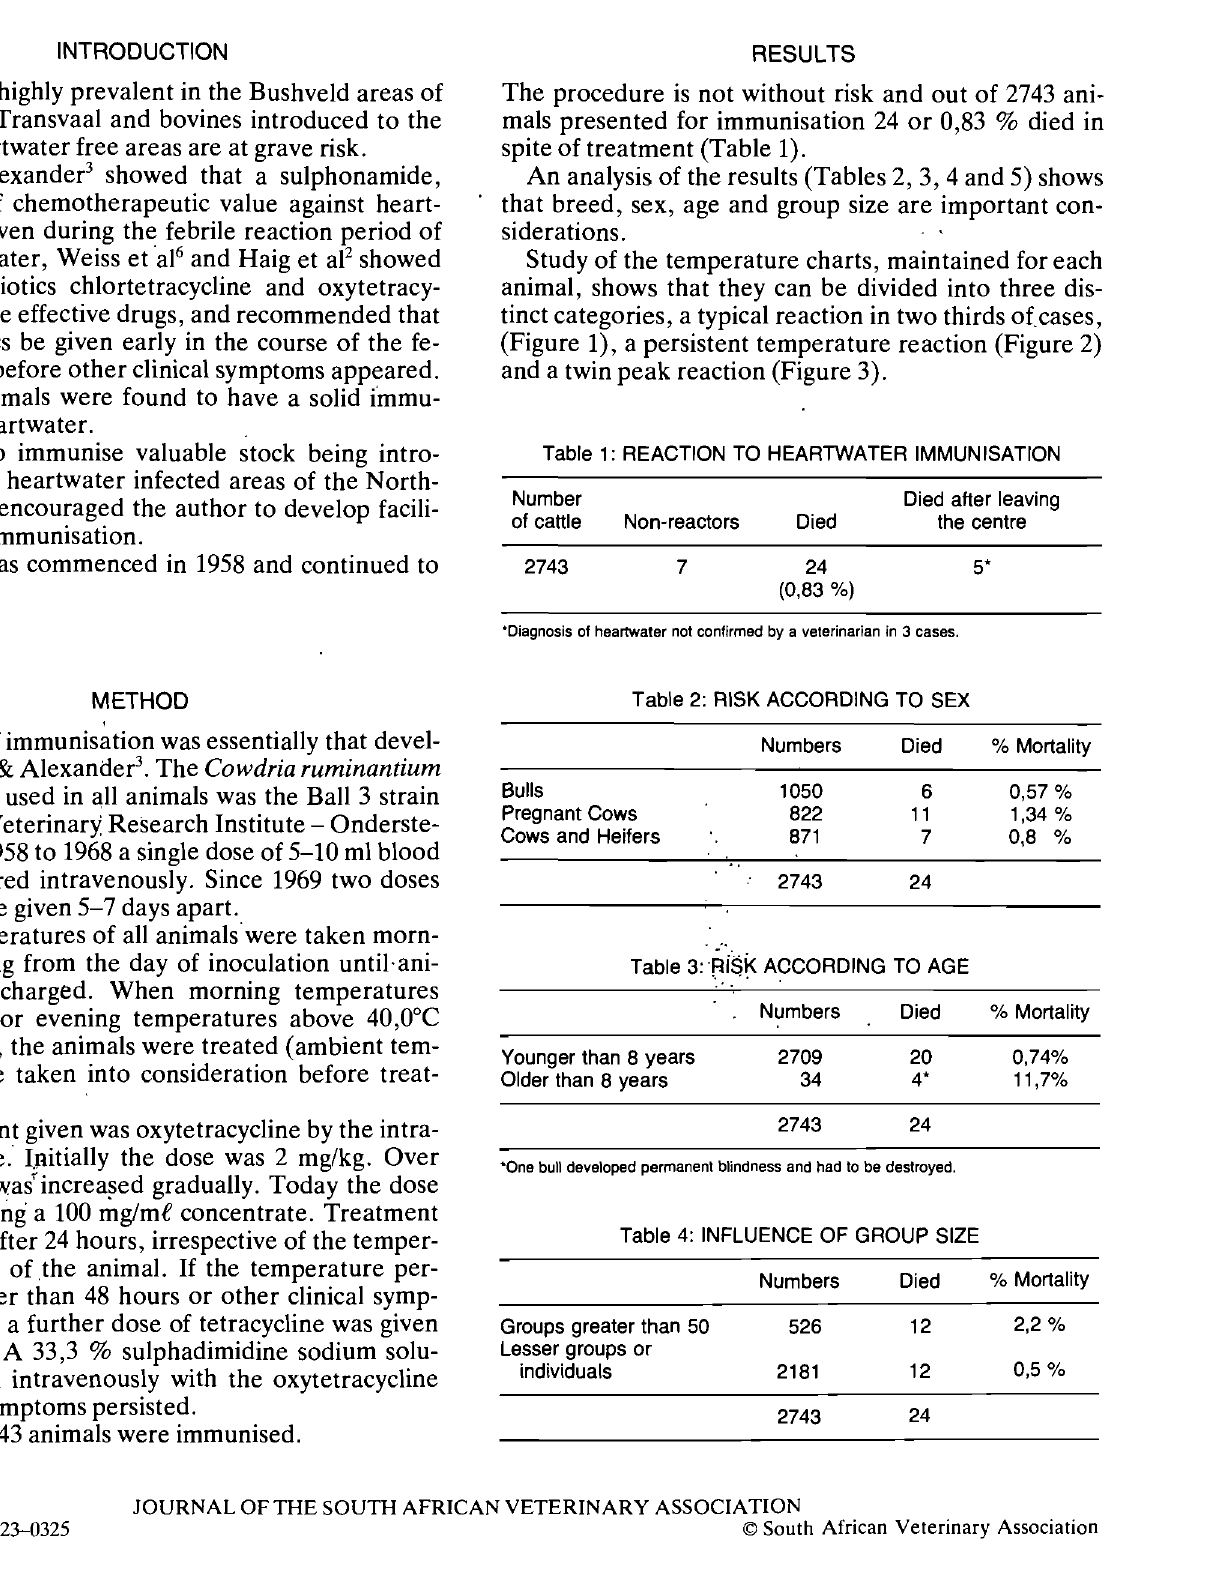
Table 4: INFLUENCE OF GROUP